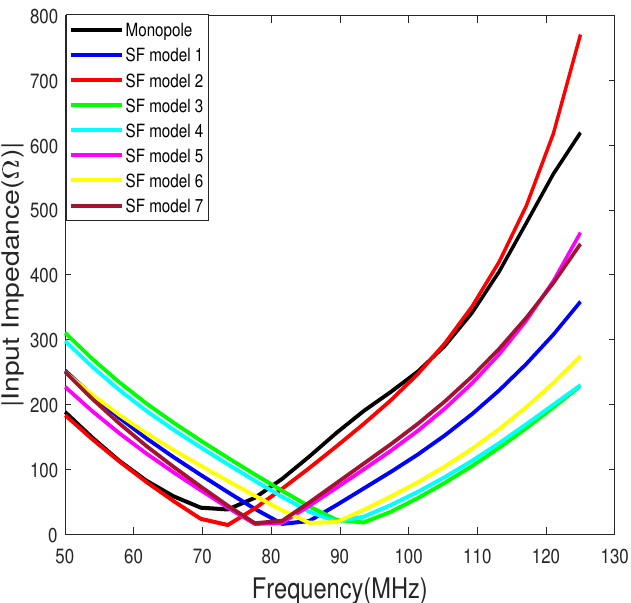
Figure 22. The magnitude of the input impedance of the monopole and the single-fold antenna modals from FEKO.